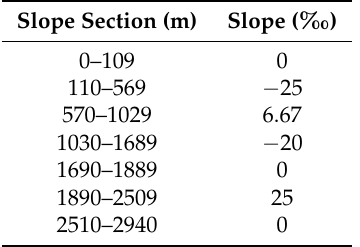
Table 4. The ramp parameters from New Port in Lvshun to Tieshan town.